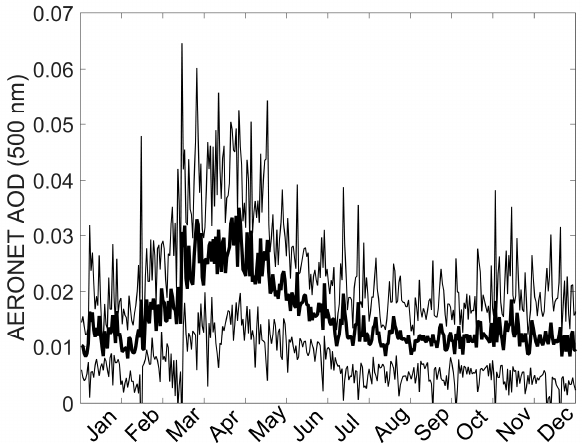
Figure 7. Bold and thin solid line denote daily mean AOD and corresponding one standard deviation, respectively, obtained from yearly time series observed at the AERONET Mauna Loa station during the period 2003–2016.